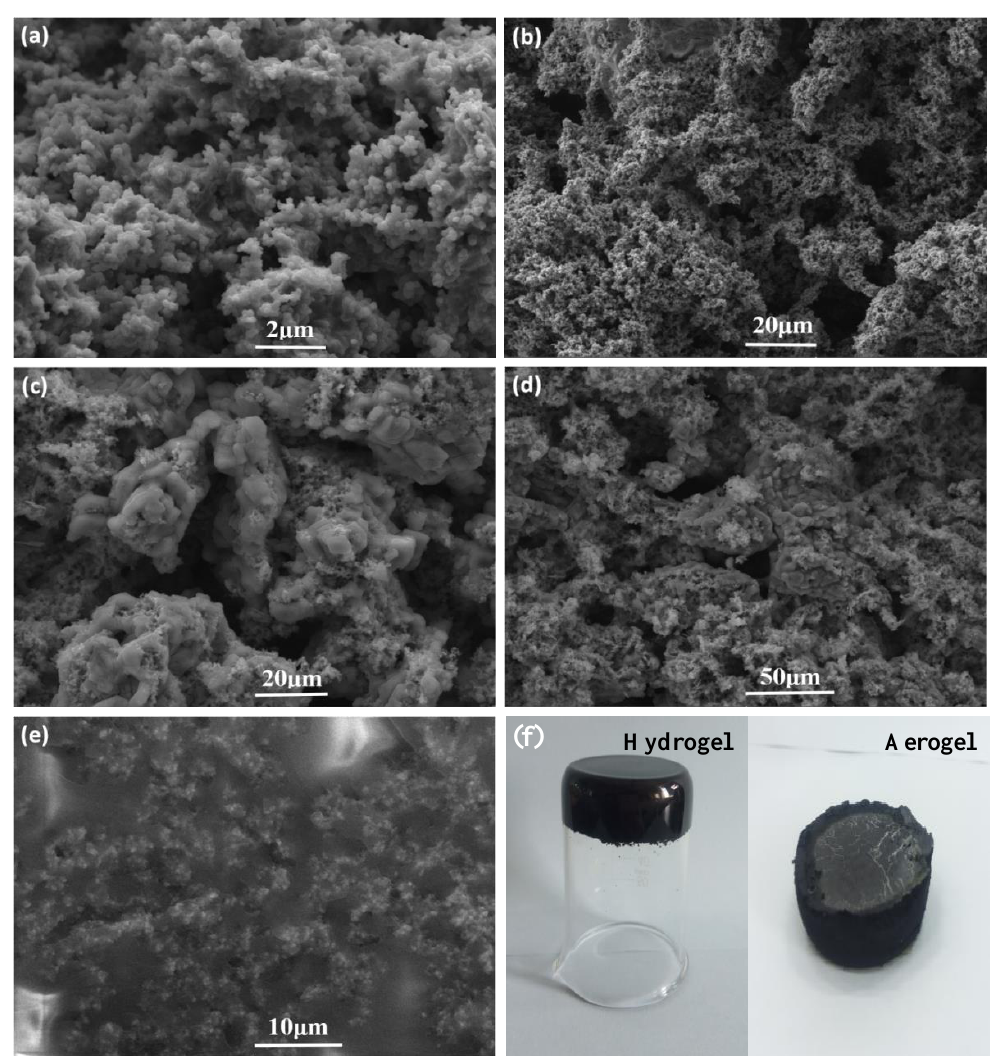
Figure 2. The SEM images of ( a ) and ( b ) PPy aerogel, ( c ) and ( d ) PPA-75, and ( e ) PPAE-75; ( f ) the photos of the prepared PZT@PPy hydrogel and aerogel.